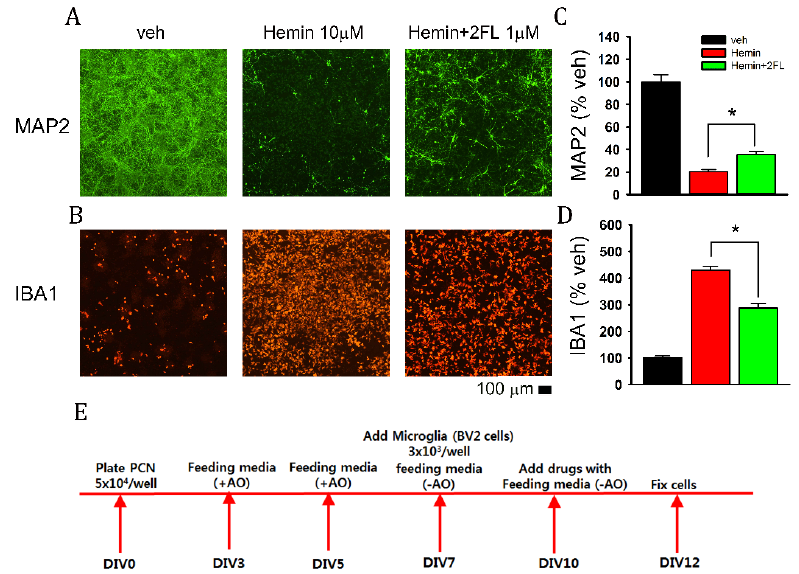
Figure 1. The neuroprotective effect of 2FL in a primary cortical neuron and BV2 microglia coculture. ( A ) Representative photomicrographs demonstrate that hemin reduced MAP2 immunoreactivity (-ir). Coadministration with 2FL antagonized the hemin-mediated loss of MAP-ir. ( B ) Hemin increased IBA1-ir. Coadministration with 2FL reduced IBA1-ir. ( C , D ) Pixel density of MAP2-ir or IBA1-ir was analyzed using NIS Elements AR 5.11 Software. ( C ) 2FL significantly antagonized hemin-mediated loss of MAP2-ir. ( D ) 2FL significantly attenuated hemin-induced IBA1 activity. ( E ) Timeline of experiment. * p < 0.05. Scale bar = 100 µ